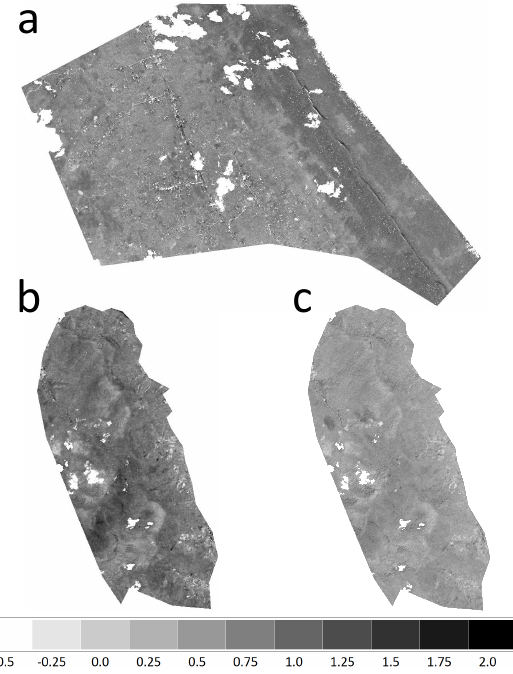
Figure 11. Malleability of the ( a ) Guiuan 2014, ( b ) Tacloban 2014, and ( c ) Tacloban